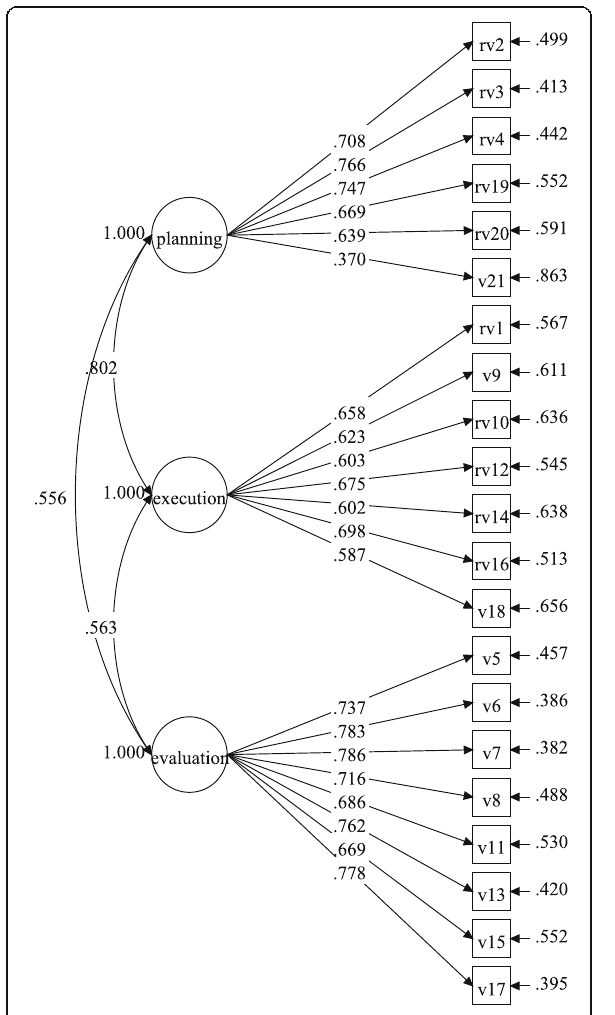
Fig. 1 Factor loadings for the three-factor model in the girls ’ group Fig. 2 Factor loadings for the three-factor model in the boys ’